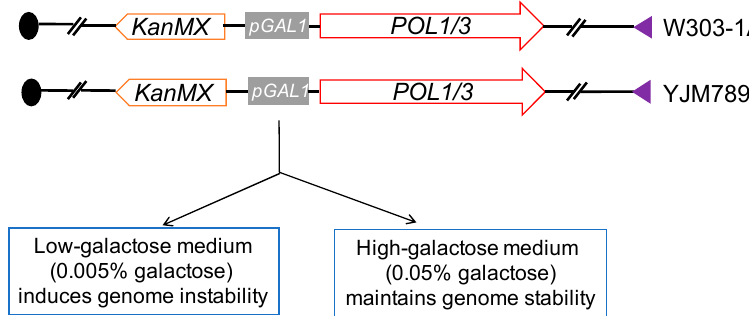
Figure 4. Yeast strains used to analyze the effects of low levels of DNA polymerase on genome stability. Two types of strains were constructed, one homozygous for a GAL-POL1 gene (a galactose-inducible promoter fused to the coding sequence of POL1 , encoding the catalytic subunit of Pol α ) and one homozygous for GAL-POL3 (the GAL promoter fused to the gene encoding the catalytic subunit of Pol δ ). When these strains are grown in low levels of galactose, the amount of the relevant DNA polymerases is reduced by about a factor of 10, resulting in genomic instability. Cells grown in high-galactose medium have relatively stable genomes.